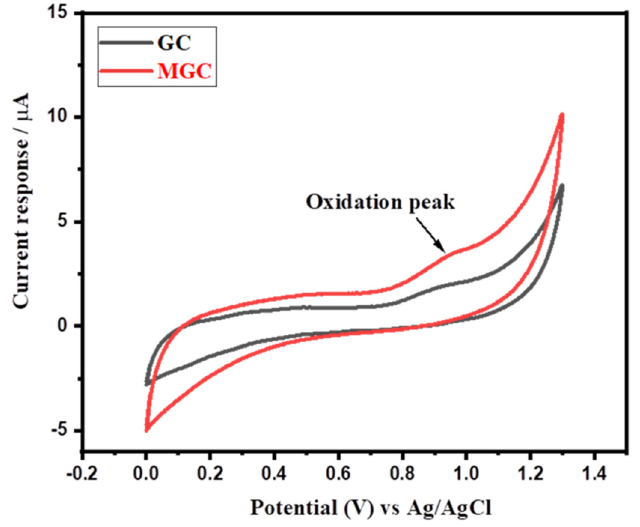
Figure 3. CV response of the GC and MGC for 50 µM RS at a scan rate of 50 mV/s.